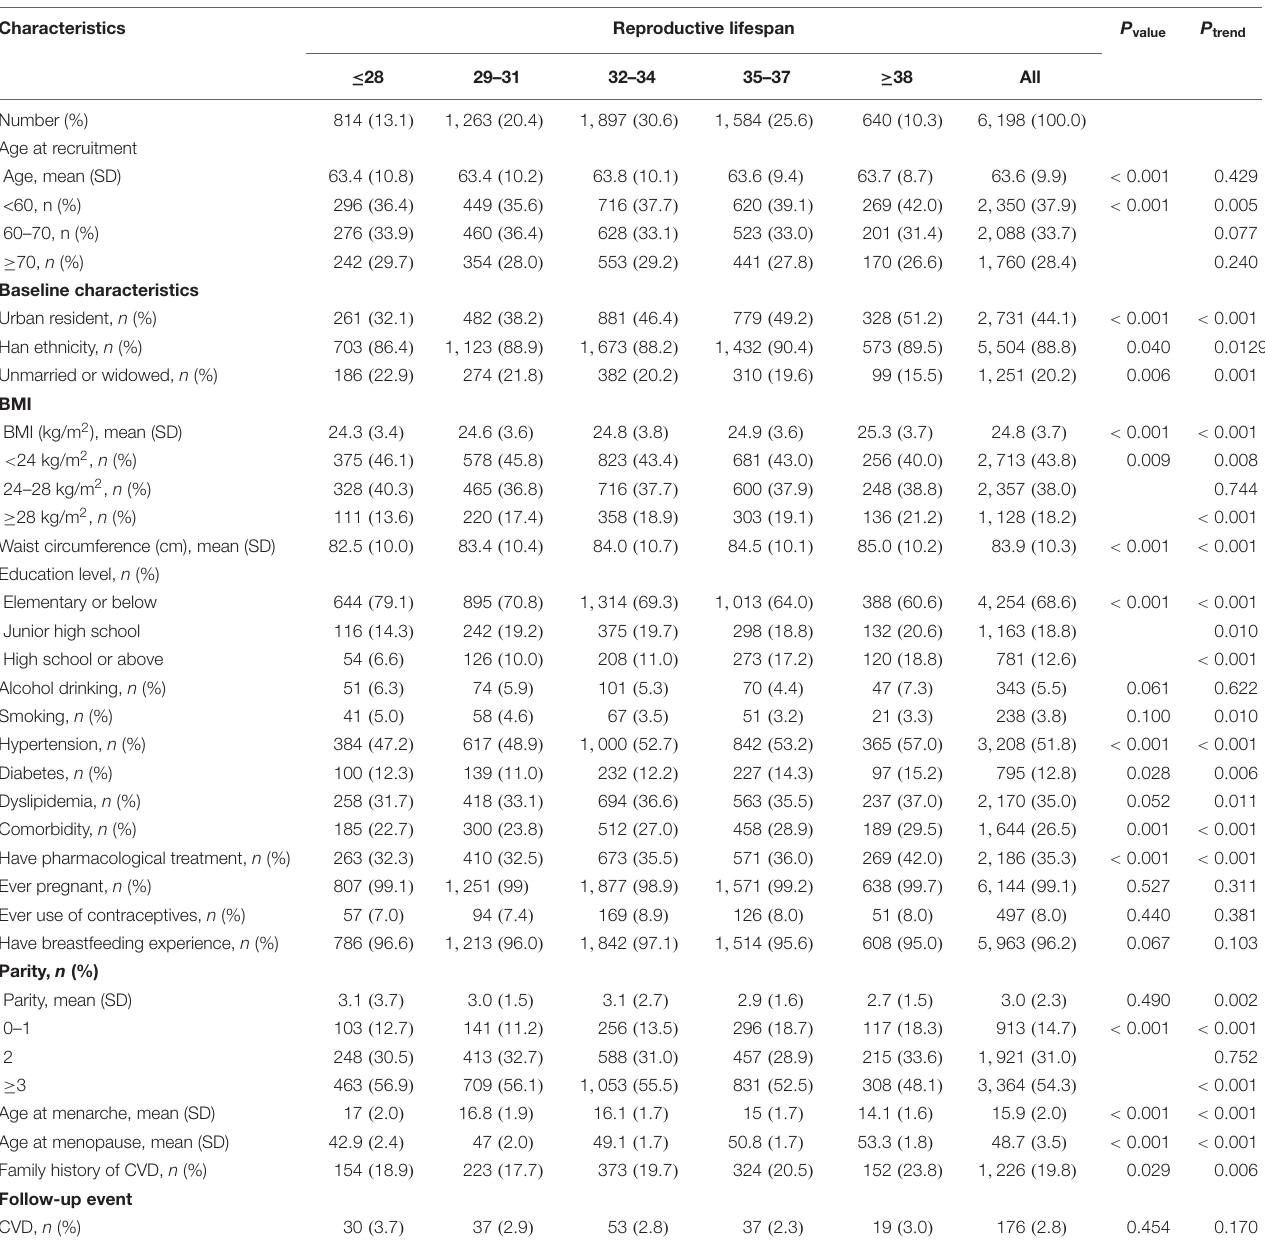
TABLE 3 | Characteristics of study participants by reproductive